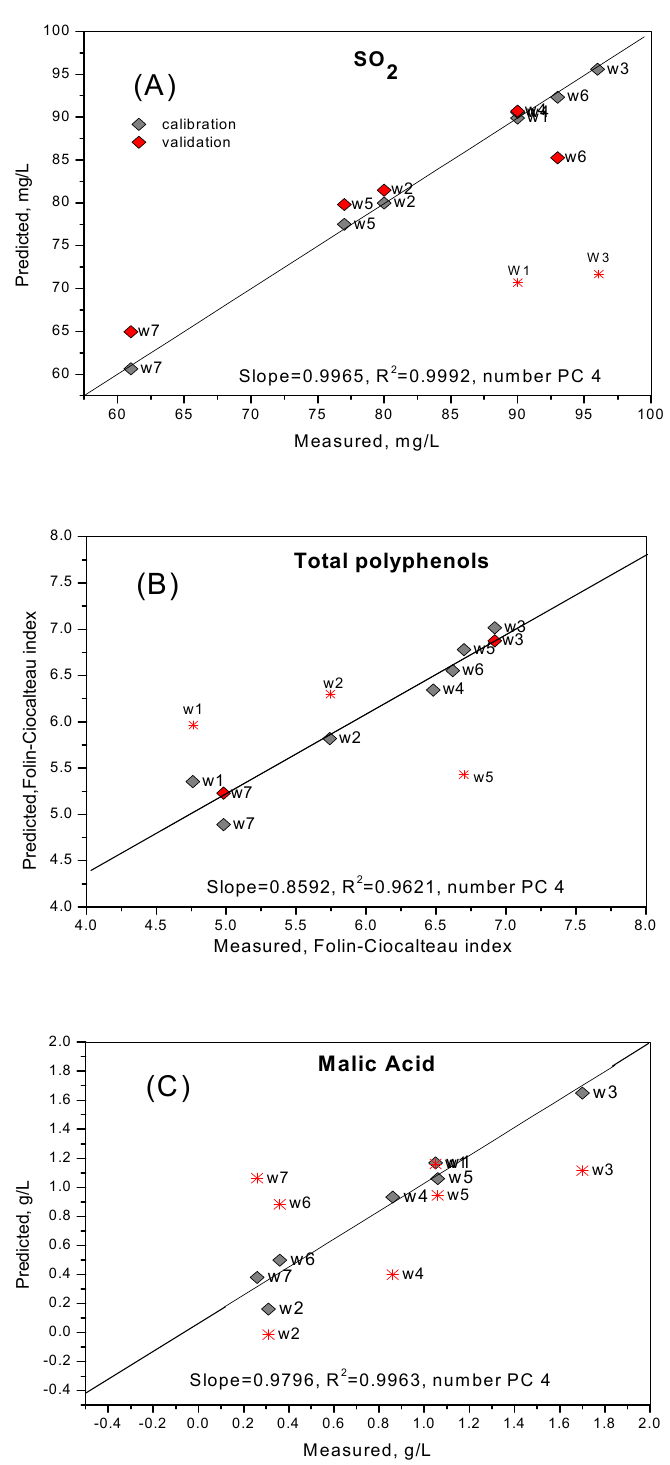
Figure 3. Results porphyrin-based ET application in Verdicchio white wines for determination of: (A) SO -content, PLS model: Slope 0.9965, R 2 0.9992, number PC 4; (B) Total Polyphenols (vs Folin- 2 Ciocalteau index), PLS model: Slope 0.8592, R 2 0.9922, number PC 4; (C) Malic Acid, PLS model: Slope 0.9797, R 2 0.9963, number PC 4; Wine samples: w1- ‘Caldirola’, 2002, w2- ‘Casal